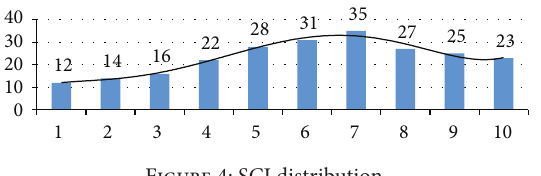
Figure 4: SCI distribution.